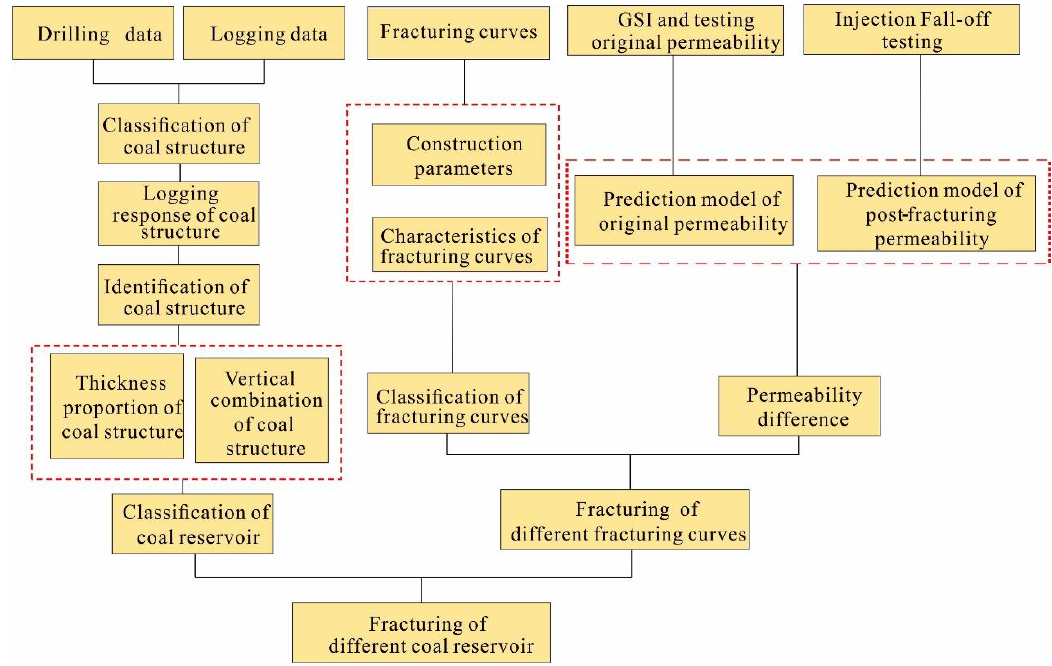
Figure 2. The workflow of the research.